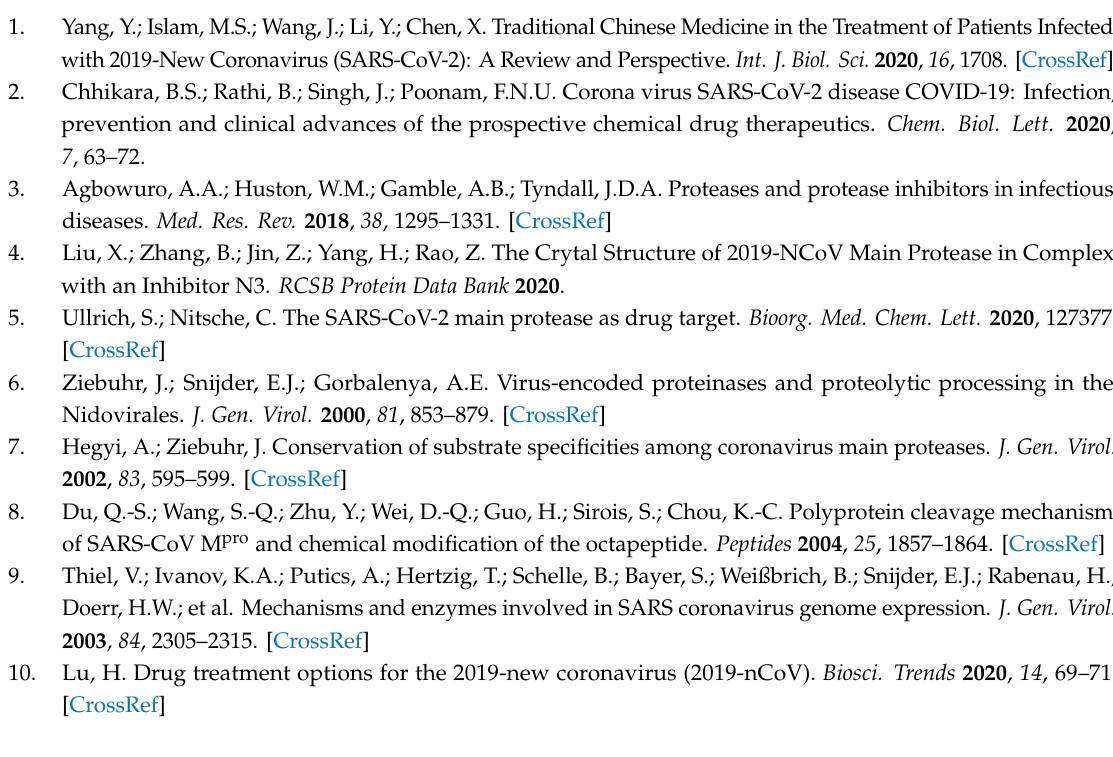
Supplementary Materials: Thefollowingareavailableonline. FigureS1: 2Dand3DinteractionsofBenzeneethanamine (A) and Camphenol (B) with the active site of SARS-CoV-2 M pro (PDB ID: 6W63); Figure S2: 2D and 3D interactions of Strophanthidin (C) and Retinal (D) with the active site of SARS-CoV-2 M pro (PDB ID: 6W63); Figure S3: 2D and 3D interactions of Trans-geranylgeraniol (E) and 3,4-Dihydroxymandelic acid (F) with the active site of SARS-CoV-2 M pro (PDB ID: 6W63); Figure S4. 2D and 3D interactions of Imidazolidin-4-one, 2-imino-1-(4-methoxy-6-dimethylamino-1,3,5-triazin-2-yl) (G) and Retinol (F) with the active site of SARS-CoV-2 M pro (PDB ID: 6W63); Figure S5: 2D and 3D interactions of alpha-Santalol (I) and Santalol, E-cis,epi-.beta- (J) with the active site of SARS-CoV-2 M pro (PDB ID: 6W63); Figure S6: 2D and 3D interactions of Spiro[4,5]dec-6-en-1-ol, 2,6,10,10-tetramethyl (K) and 3.beta-Hydroxy-5-cholen-24-oic acid (L) with the active site of SARS-CoV-2 M pro (PDB ID: 6W63); Figure S7: 2D and 3D interactions of Phosphonoacetic acid, 3TMS derivative (M) and Nordazepam, TMS derivative (N) with the active site of SARS-CoV-2 M pro (PDB ID: 6W63); Figure S8: 2D and 3D interactions of 2,6-Dihydroxybenzoic acid, 3TMS derivative (O) and aR-Turmerone (P) with the active site of SARS-CoV-2 M pro (PDB ID: 6W63); Figure S9: 2D and 3D interactions of (Z)-.gamma.-Atlantone (Q) and Verbenyl angelate, cis- (R) with the active site of SARS-CoV-2 M pro (PDB ID: 6W63); Figure S10. 2D and 3D interactions of Tumerone (S) and Dibutyl phthalate (T) with the active site of SARS-CoV-2 M pro (PDB ID: 6W63); Figure S11: 2D and 3D interactions of (-)-Globulol (U) and Androstan-17-one, 3-ethyl-3-hydroxy-, (5.alpha) (V) with the active site of SARS-CoV-2 M pro (PDB ID: 6W63); Figure S12: 2D and 3D interactions of Yangambin (W) with the active site of SARS-CoV-2 M pro (PDB ID: 6W63); Figure S13: 2D and 3D interactions of Nelfinavir (X) and Lopinavir (Y) with the active site of SARS-CoV-2 M pro (PDB ID: